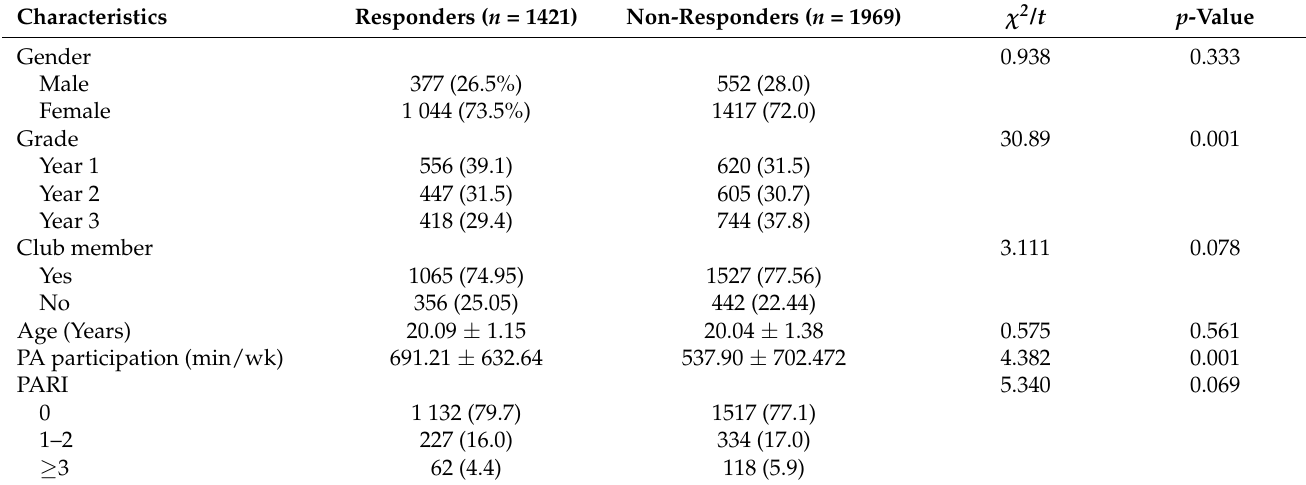
Table 1. The differences between participants who agreed to participate in the interview and those who refused to participate.